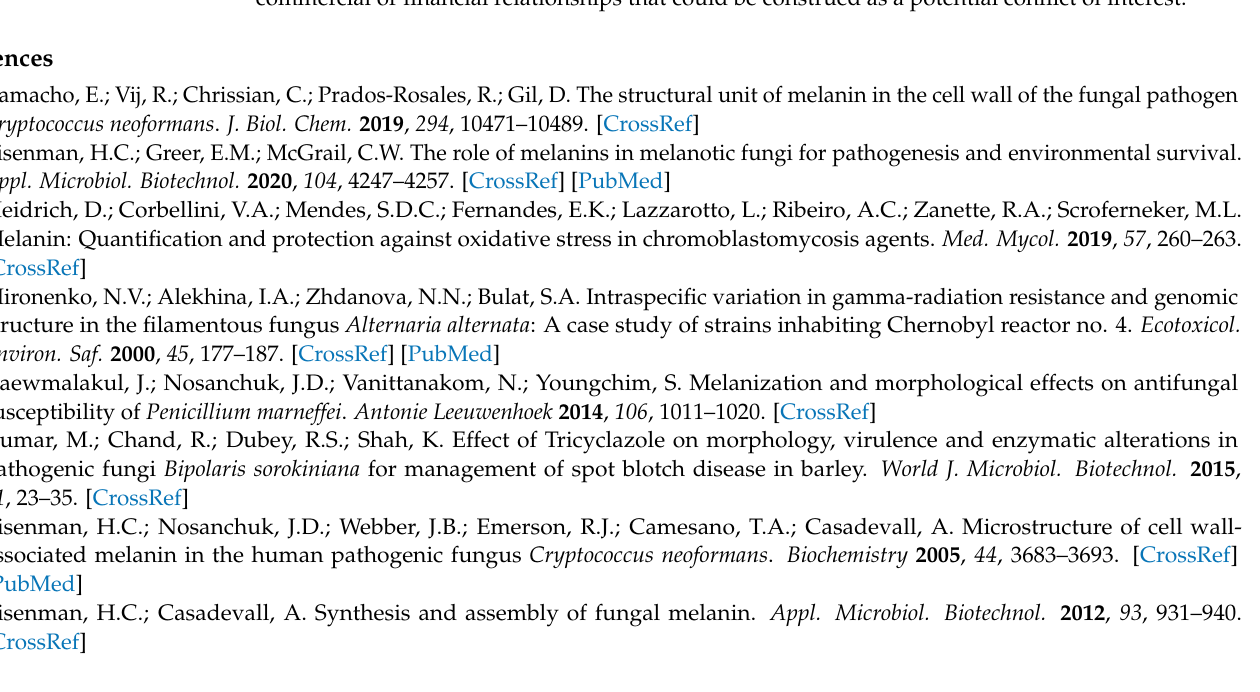
deletion mutants. Table S1: Primers used for gene knockout and validation. Table S2: Primers used in quantitative real-time